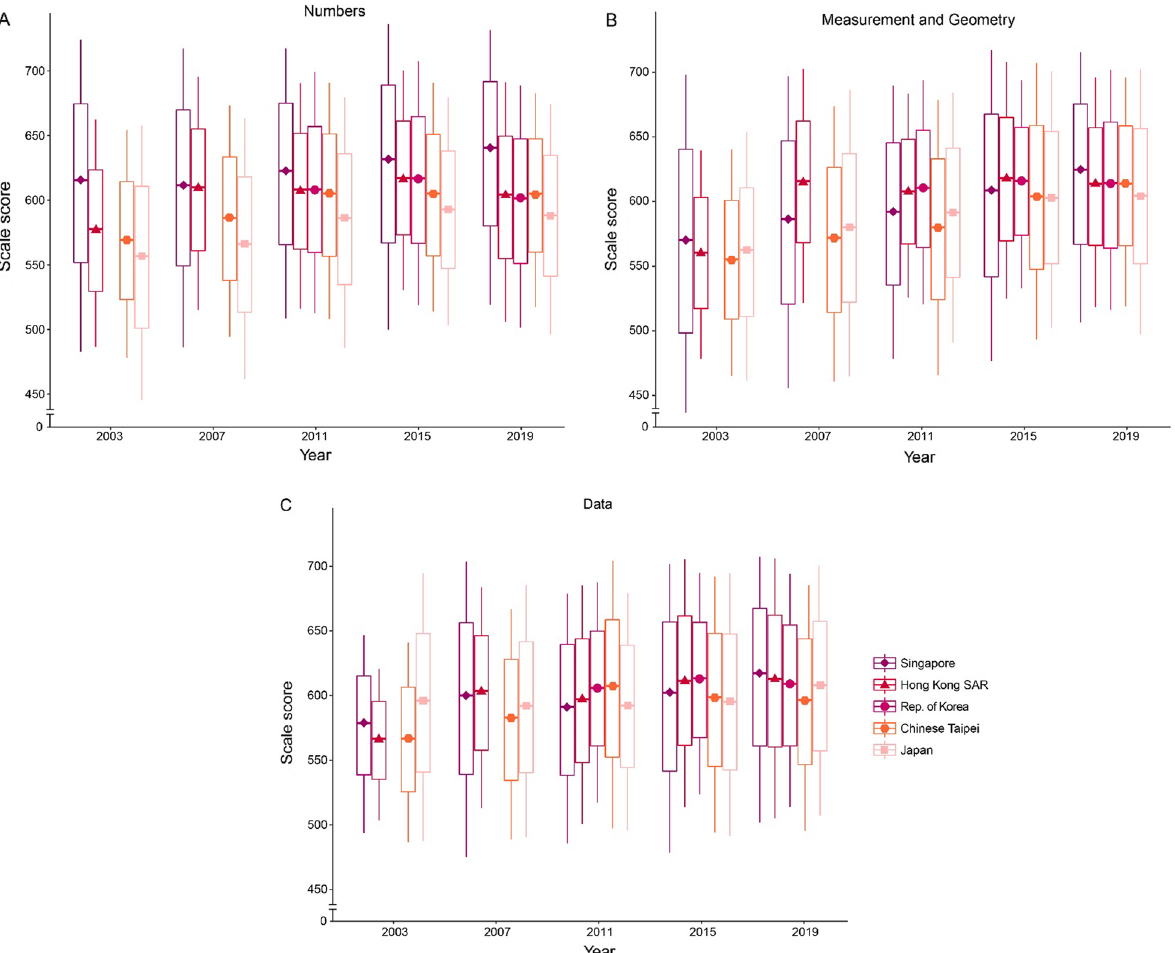
Fig. 5 Mathematics attainments of Singapore and East Asian countries in TIMSS 2003–2019. Grade 4 (equivalent to Primary 4) scale scores for A numbers, B measurement and geometry and C data domains. Lower quartile, median and upper quartile define each box. Lower and upper whiskers represent 10th and 90th percentile, respectively. Rep. of Korea did not participate in 2003 and